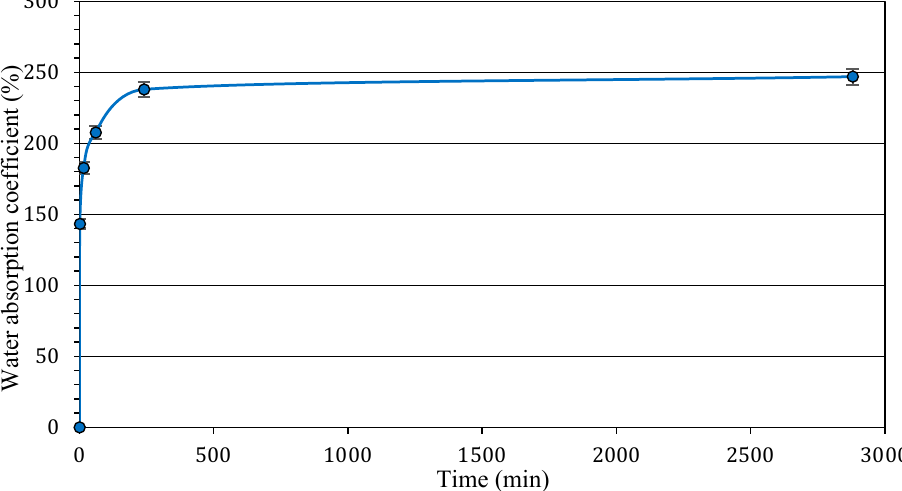
Table 1. Chemical composition of cement and pozzolans used in this